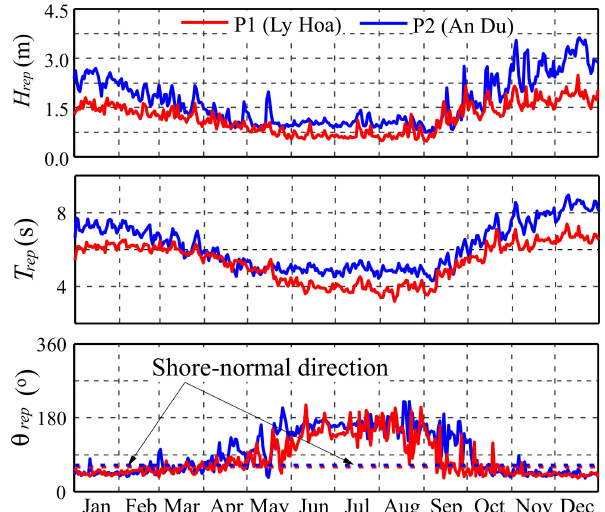
Figure 3. Daily-averaged wave energy from